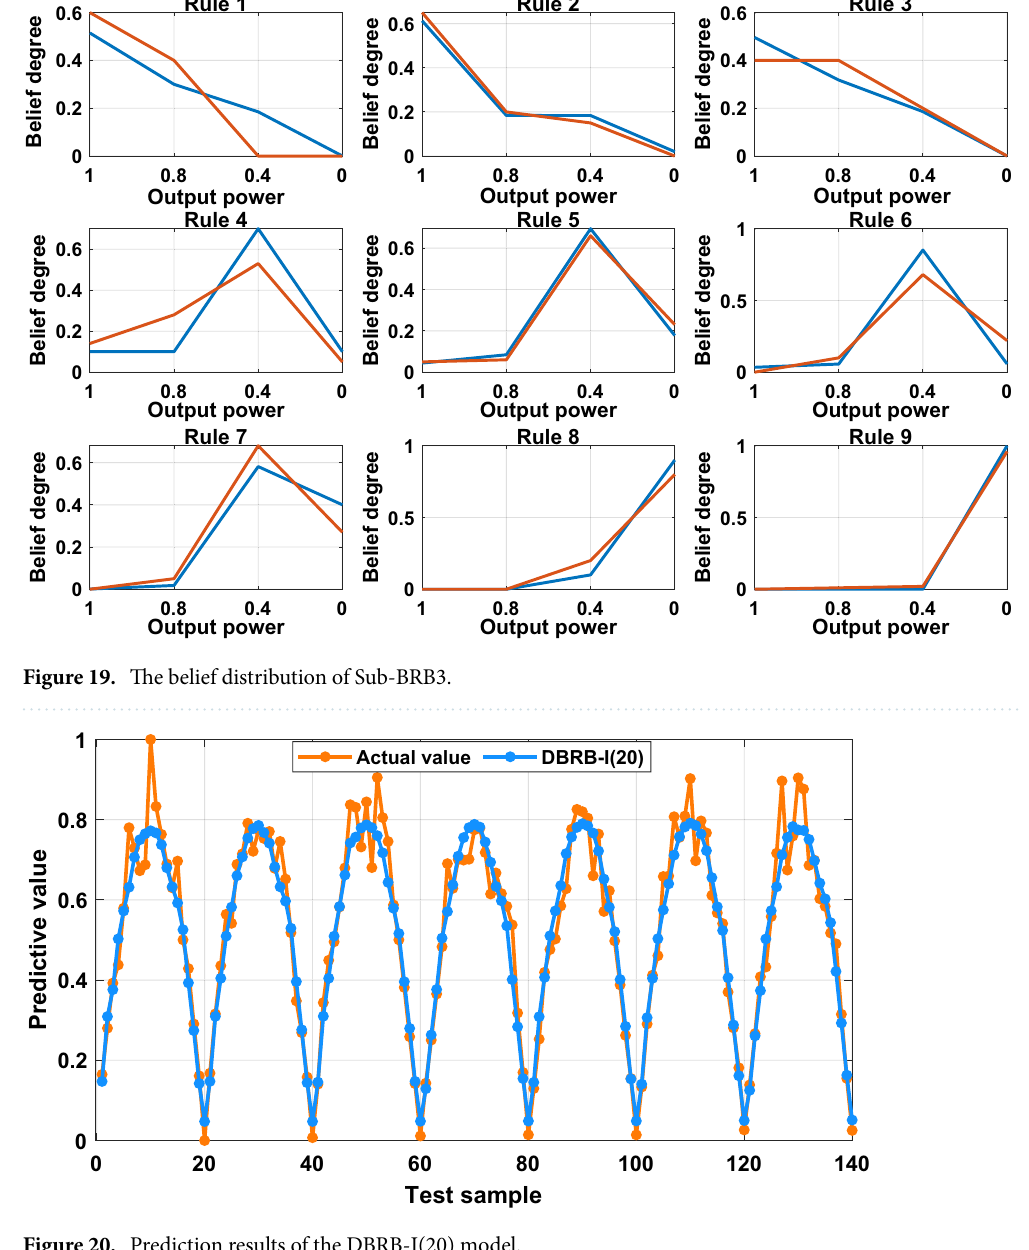
Figure 20. Prediction results of the DBRB-I(20)